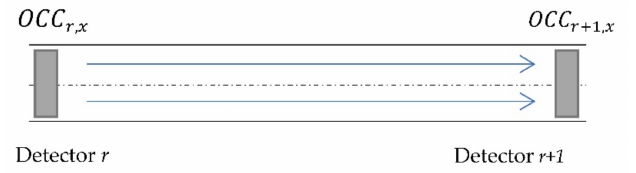
Figure 2. Sample section of a freeway for California #7 AID